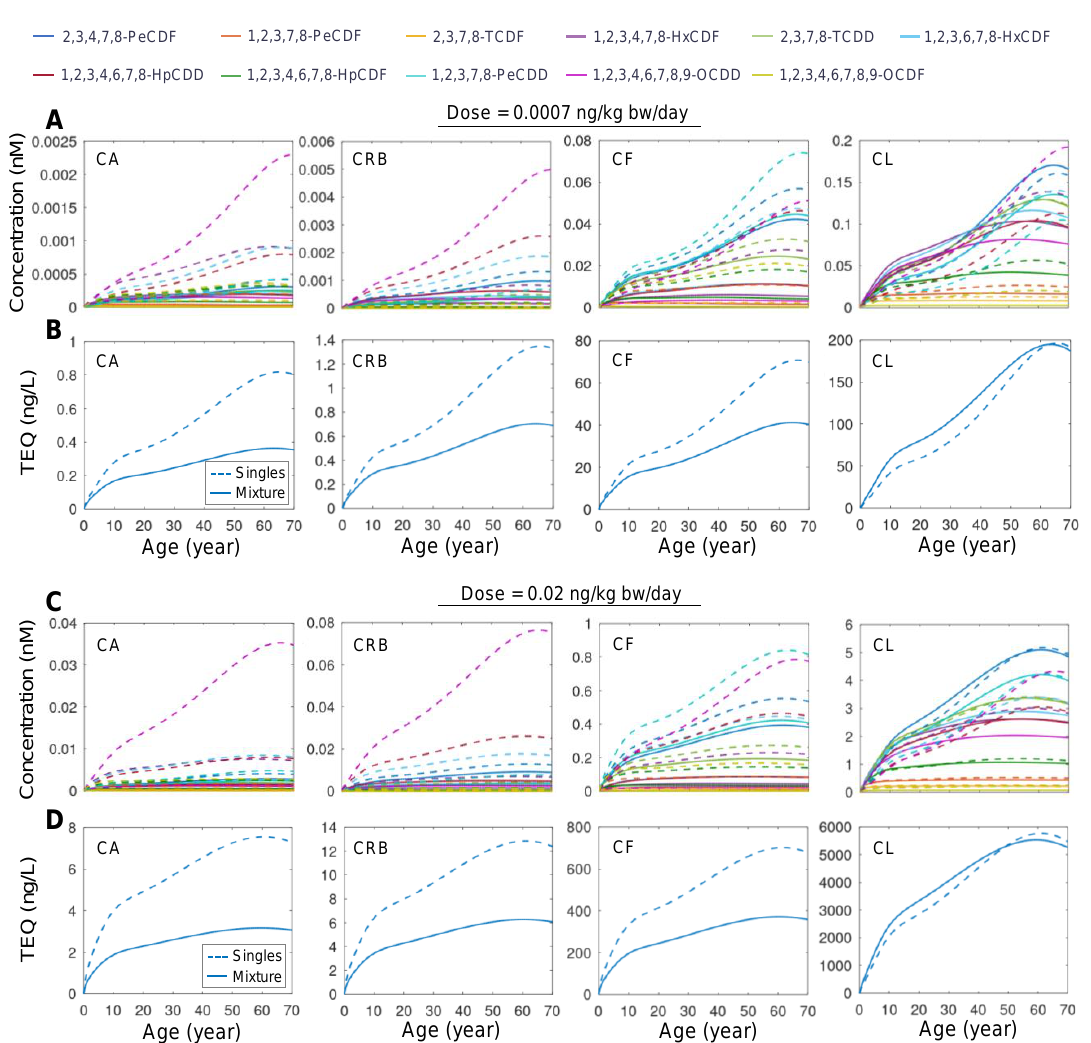
Figure 4. Simulation results for mixture exposure to 11 DLCs. ( A ) Predicted time-course of CA , CF , CRB , and CL for lifetime exposure to mixture of 11 DLCs (solid line) or single DLC (dashed line) as indicated at a dose of 0.0007 ng/kg bw/day for each congener. ( B ) Tissue TEQ values calculated based on the concentrations in ( A ) using systemic TEF. ( C , D ) Same as ( A , B ) but for high-dose exposure at 0.02 ng/kg bw/day for each congener.